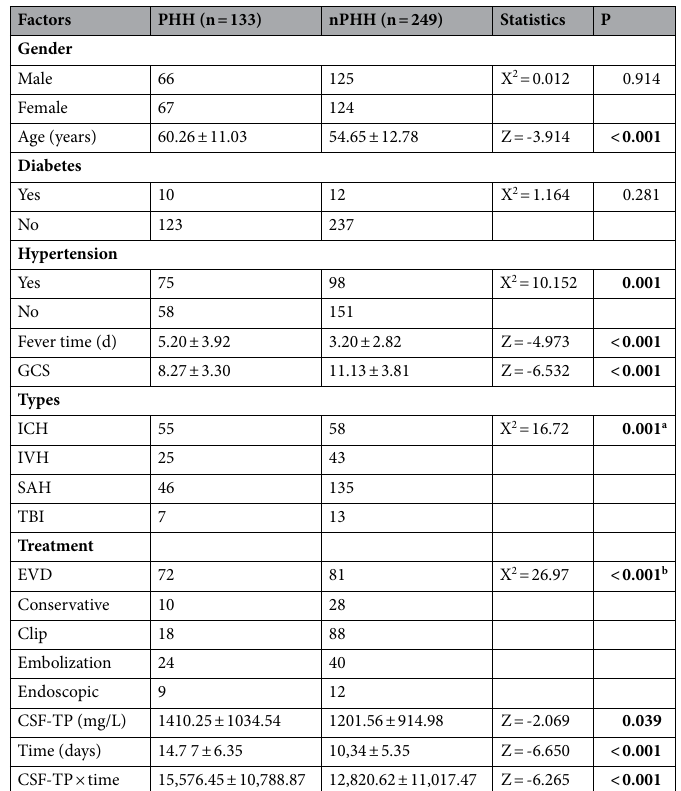
statistical significance between ICH and SAH. b There was statistical significance between EVD and clipping, and between clipping and intervention.